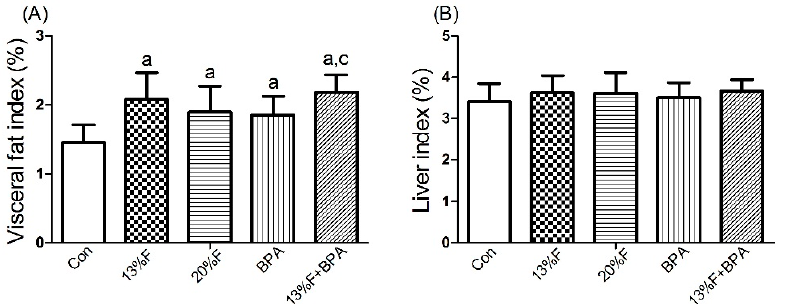
Figure 1. Effects of fructose and/or BPA exposure on index. ( A ) Visceral fat index; ( B ) Liver index of male rats after eight weeks of treatment with fructose and/or BPA. Values are expressed as means ± SD, n = 10. Differences between groups were considered as significant at p < 0.05 and were analyzed with one-way ANOVA. a different compared to Con; b different compared to 13% F; c different compared to BPA ( p < 0.05). Con, control group; F, fructose group; BPA, 1 µg/mL BPA group.